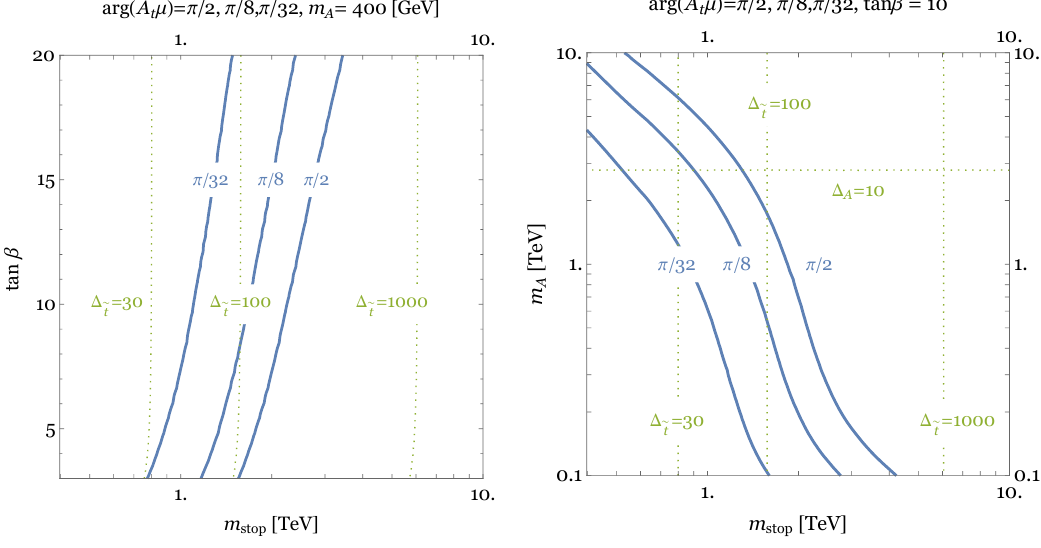
Figure 8 . The implication of the EDM bound in the ACME II experiment on the stop parameter space assuming some other interactions to explain the correct Higgs mass. The A -term is still radiatively generated from the gluino mass. The parameters are taken to be the same values as those of (cid:12)gure 7. The blue curves denote the ACME II constraint with phases arg( A t (cid:22) ) = (cid:25)= 2 ; (cid:25)= 8 ; (cid:25)=